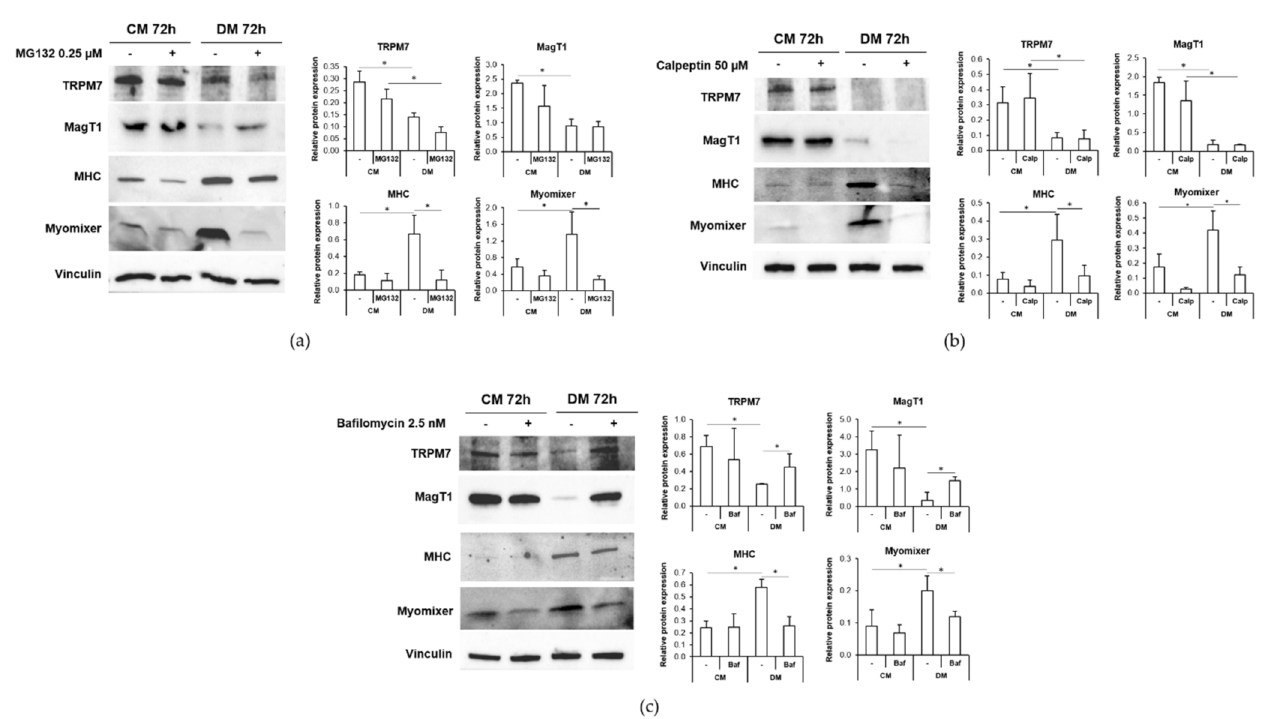
Figure 4. Autophagy inhibition restores TRPM7 and MagT1 expression during myogenesis. C2C12 were cultured in CM or DM for 72 h in the presence of the proteasome inhibitor MG132 (0.25 µ M) ( a ) or calpeptin (50 µ M) ( b ) or bafilomycin (2.5 nM) ( c ). TRPM7, MagT1, MHC and Myomixer expression was analyzed by western blot. Vinculin was used as control of loading. A representative blot (left panel) and densitometry performed on three independent experiments and obtained by ImageLab (right panel) are shown. To define statistical significance, non-parametric Kruskal–Wallis test was used and the p-values were corrected using the Dunn’s method. * p ≤